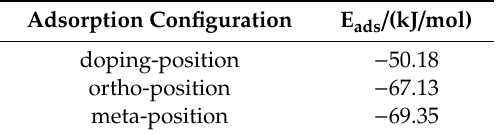
Table 2. E ads of H 2 O on di ff erent sites of the pyrite surface with carbon defects. Adsorption